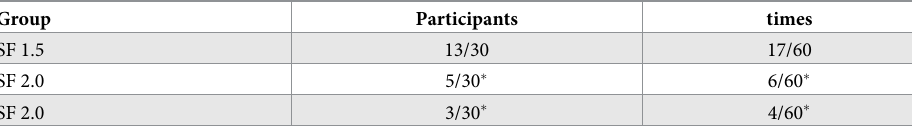
Table 4. Rescue analgesia among